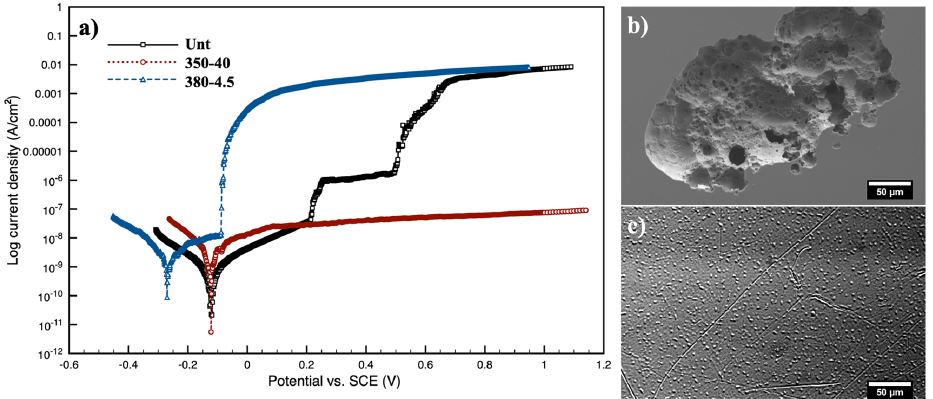
Figure 9. ( a ) Potentiodynamic polarisation curves of Unt, 350-40 and 380-4.5 samples; SEM images for ( b ) Unt (showing pitting corrosion) and for ( c ) 350-40